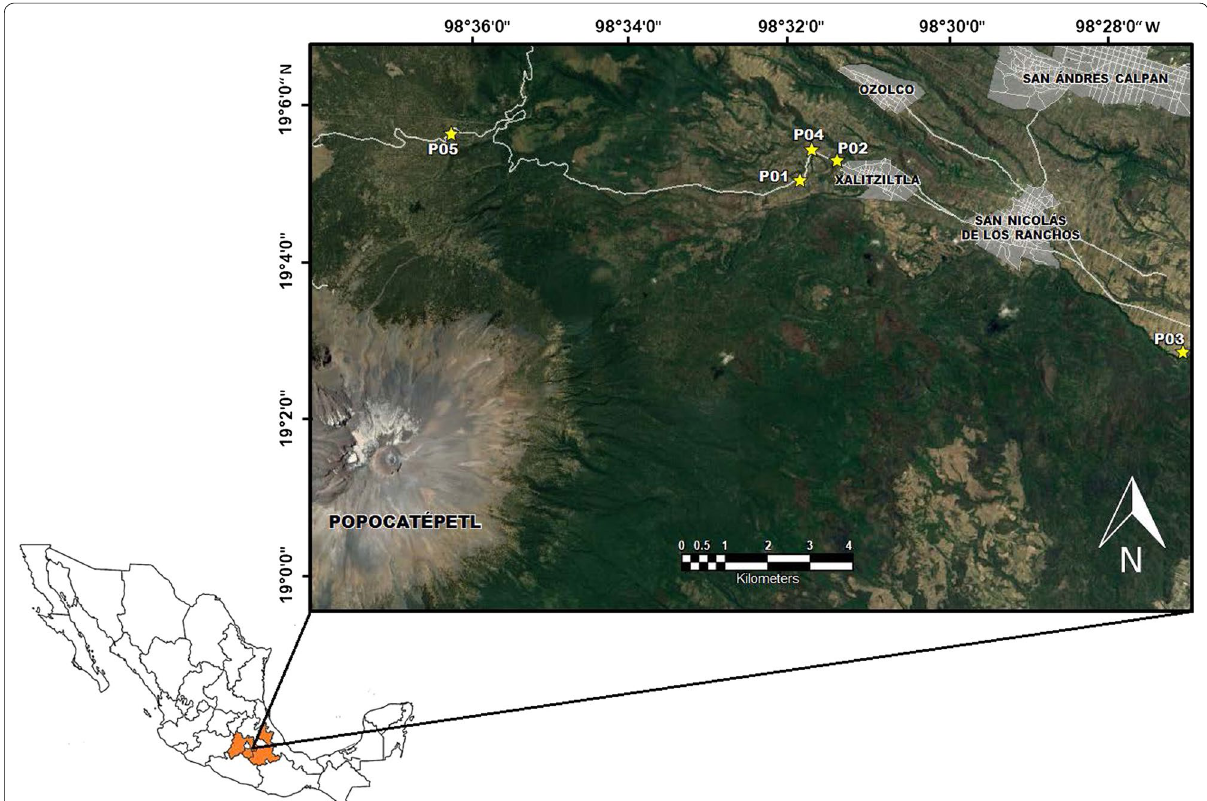
Fig. 1 Overview Google Earth image of the Popocatepetl volcano deposits/flows. Stars denote the location of the five paleomagnetic sites (PO‑1– PO‑5). Sites PO‑1 and PO‑2 correspond to pyroclastic density currents (Lorenzo and Pink Pumice, respectively), while PO‑3 (Nealtican lava flow), PO‑4 (Xalitzintla lava flow) and PO‑5 (Buenavista dacite) correspond to lava flows. See text for